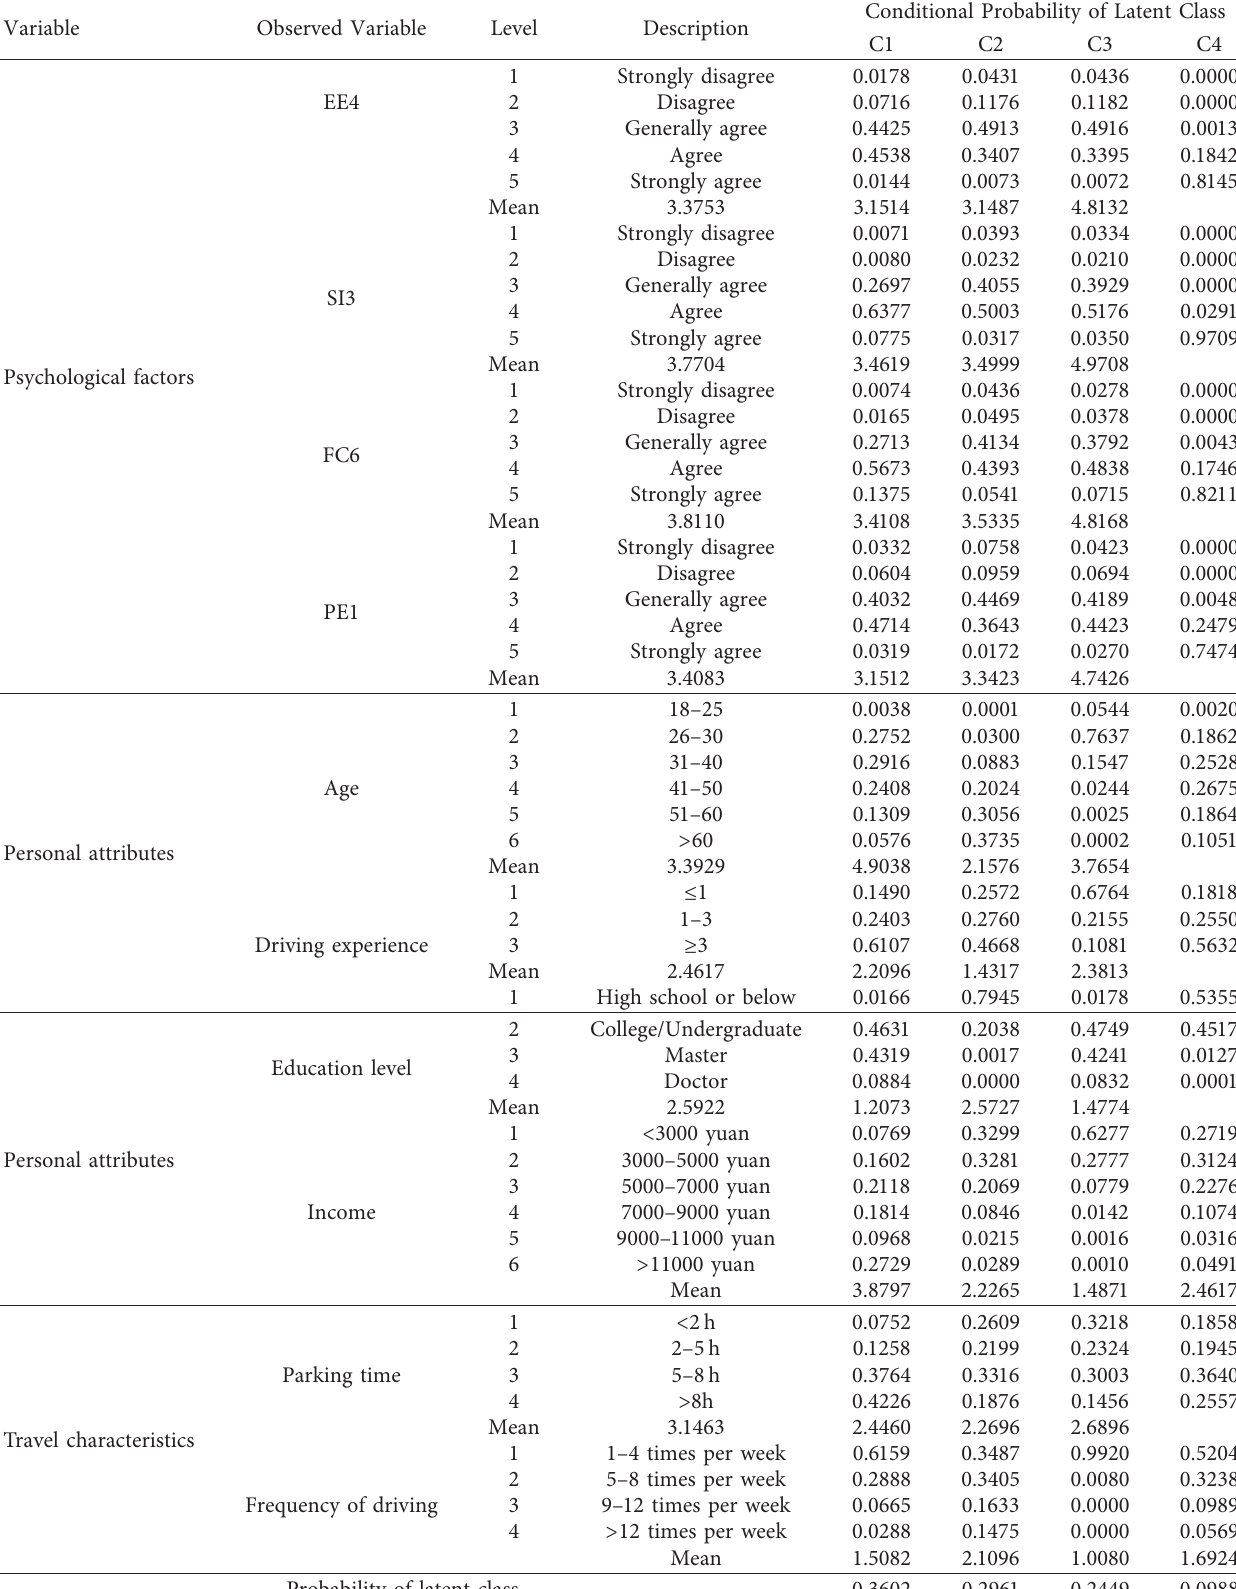
Table 6: Parameter estimation results of LCM (four latent classes: C1, C2, C3, and